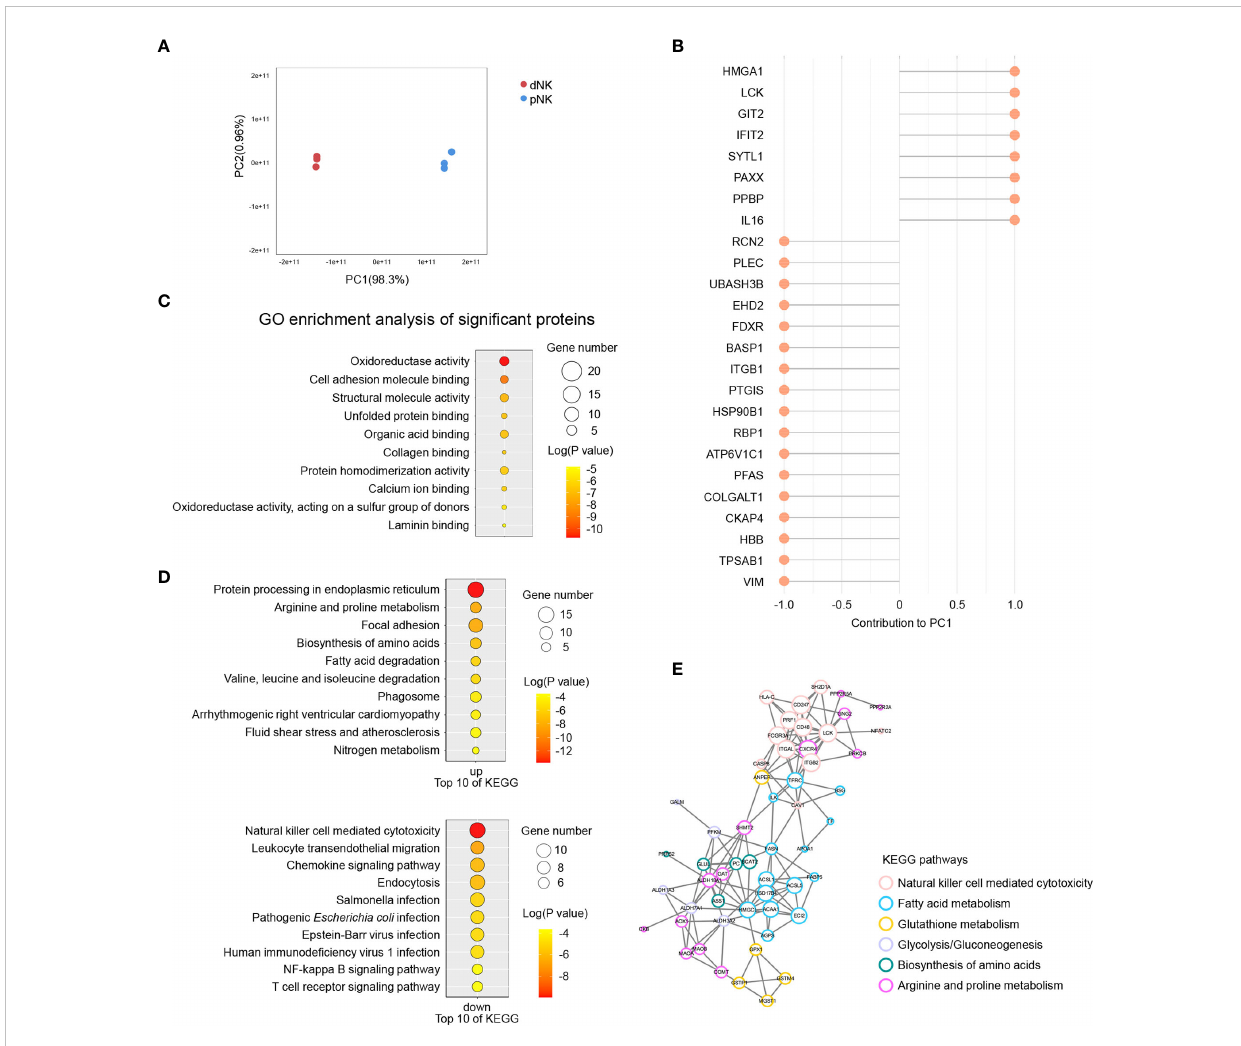
FIGURE 5 Proteomics analysis of dNK and pNK cells. (A) Principal component analysis (PCA) of dNK and pNK (ctrl) cells. Each symbol represents one donor (n=3). (B) Top 25 differentially expressed proteins (DEPs) mostly contributing to PC1. (C) GO enrichment of DEPs contributing to PC1, |loading| > 0.95. (D) KEGG enrichment of all DEPs. (E) PPI analysis of DEPs. MCODE was used to calculate the score of each DEP. The size of each circle represents the